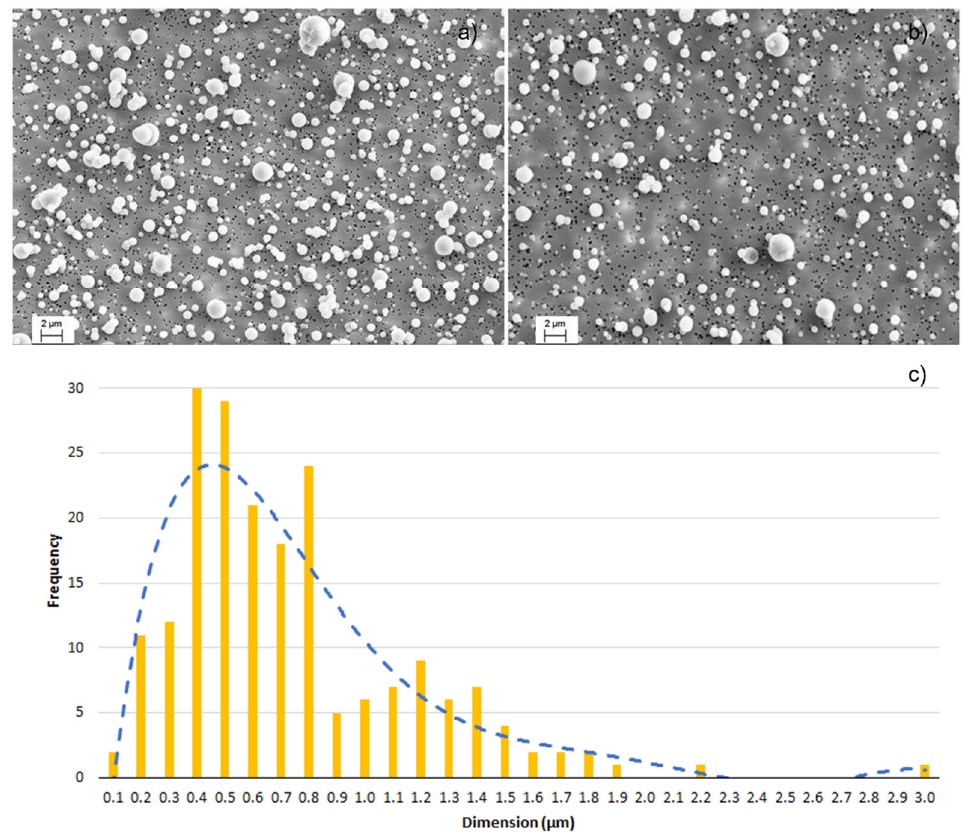
Figure 7. SEM images of ( a ) filter 1 (run 2 at 1 bar); ( b ) filter 2 (run 5 and 6 at 1.5 bar); ( c ) size distribution of AgHEC particles after spray-coating activities (mode: 0.39 µm), from SEM images.